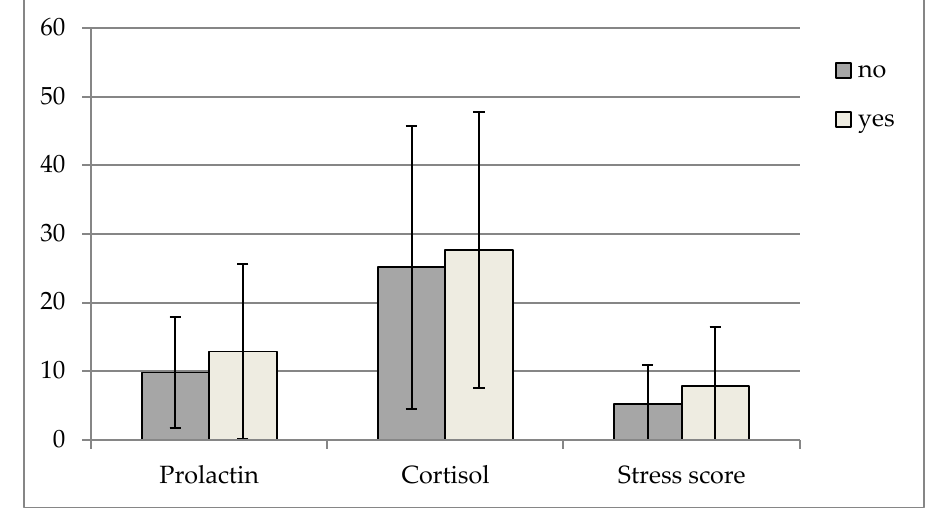
Figure 2. Results of serum prolactin, cortisol and stress score for dogs showing and not showing fearful in the collection room. Values for prolactin in serum (ng / mL), cortisol in serum (ng / mL) and stress score in dogs evaluated as showing (yes; n = 13) or not showing (no; n = 27) fearful behaviour in the collection room.